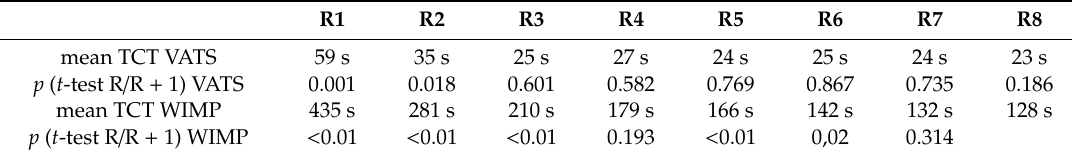
Table 1. Test results for eight trials for the VATS as well as the WIMP. In the VATS, nine trials were conducted. Thus, we also tested the trial eight vs. trial nine. The p values with a grey background indicate the significant results of the t -test between trial R(X) and trial R(X + 1). R1 R2 R3 R4 R5 R6 R7 mean TCT VATS 59 s p ( t -test R / R + 1) VATS 0.001 mean TCT WIMP p ( t -test R / R + 1)